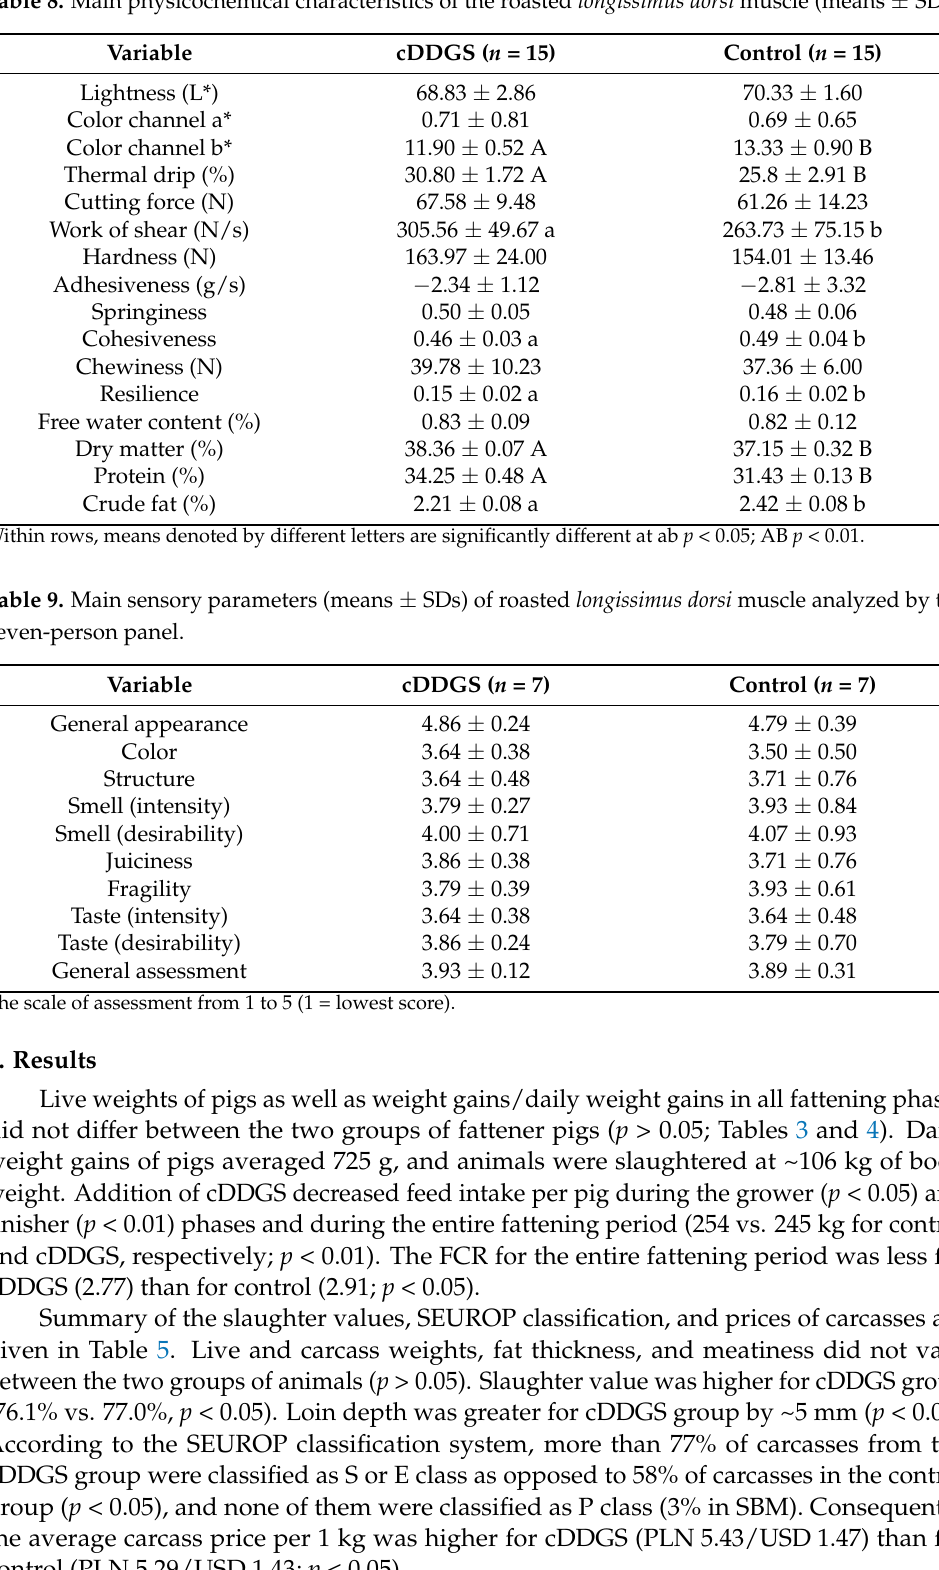
Table 8. Main physicochemical characteristics of the roasted longissimus dorsi muscle (means ± SDs).